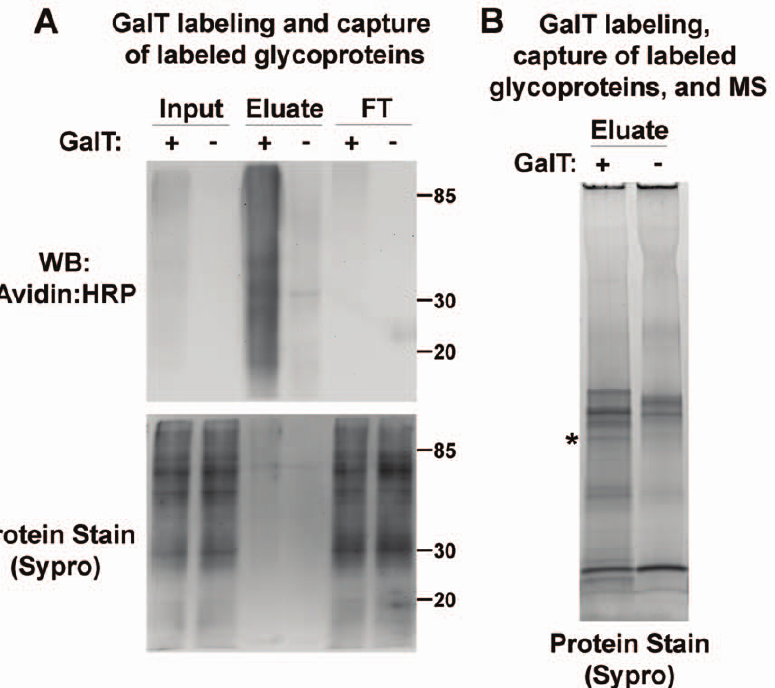
Figure 4. Actin has a glycosylated isoform in C.elegans . (A) Glycoproteins containing terminal GlcNAc were purified by first treating N2 larval lysates with both UDP-azido-GalNAc and GalT ( + ), or with UDP-azido-GalNAc alone ( 2 ), then reacting with biotin-alkyne, and finally capturing the biotinylated glycoproteins with streptavidin beads. Biotinylated glycoproteins were visualized by Western blot with avidin:HRP. (B) Eluted glycoproteins were purified as in (A), fractionated by SDS-PAGE, and the gel was stained with Sypro. Peptides shared by ACT-2, ACT-3, and ACT-4 were identified by MALDI-TOF/TOF from the asterisk-marked band, which was exclusive to the ( + ) lane.